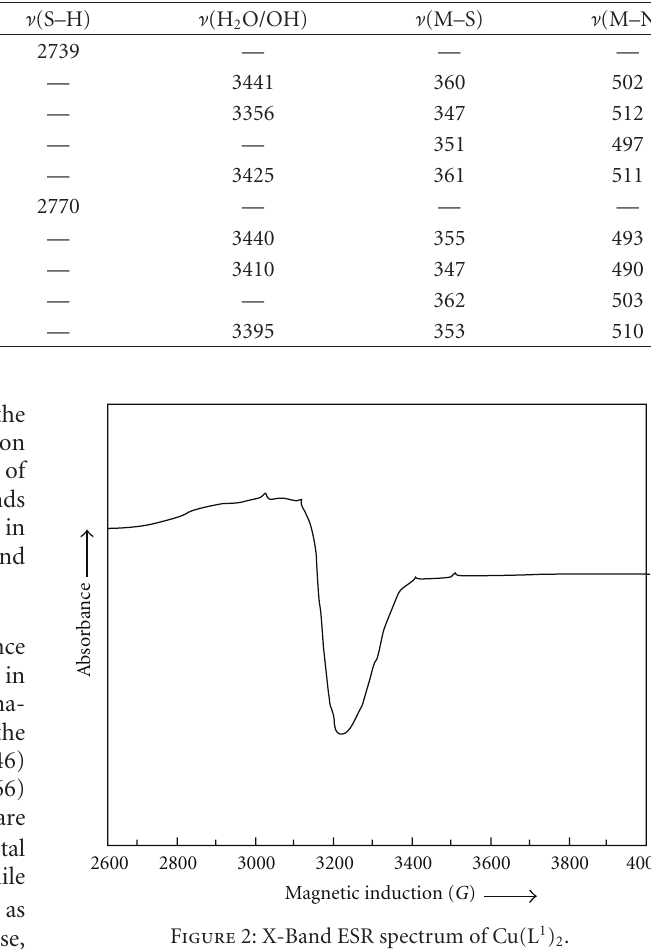
Figure 2: X-Band ESR spectrum of Cu(L 1 ) 2